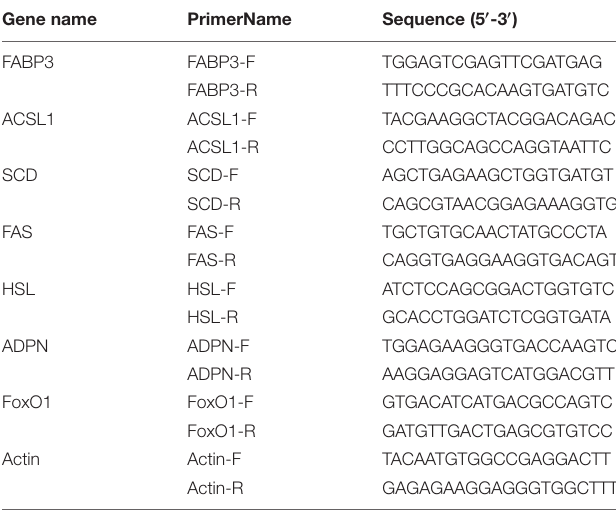
TABLE 2 | Oligonucleotide primers used for quantitative real-time